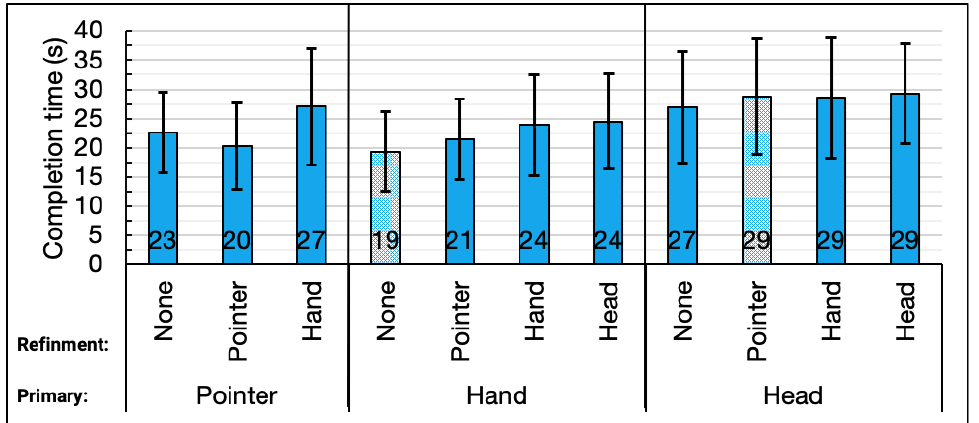
Figure 10. Mean times with different interaction techniques. Error bars represent the standard deviations and the pattern-filled bars annotate the fastest and slowest